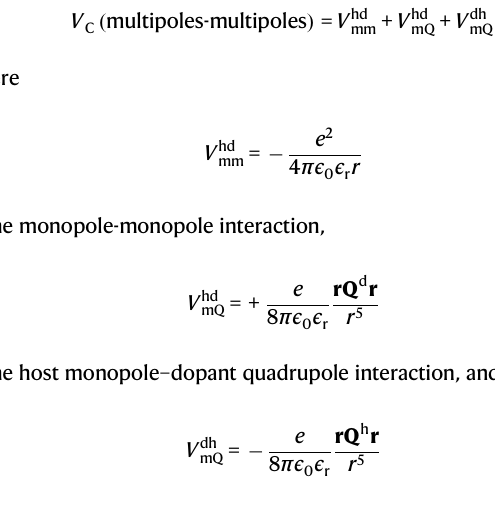
the opposite effect ð V dh